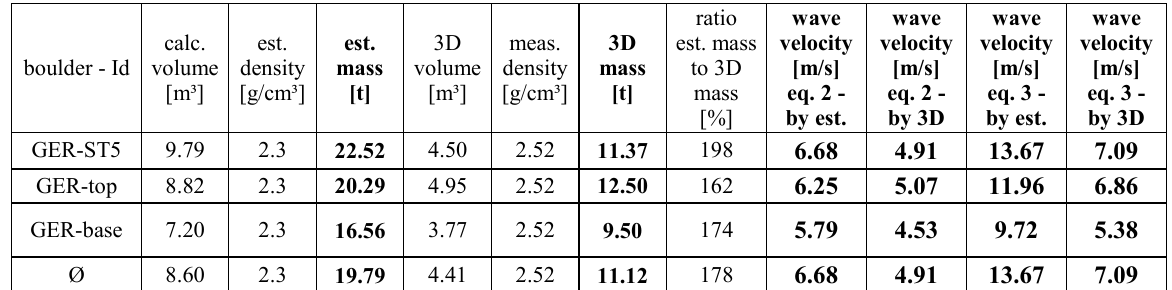
resolution digital elevation models (HRDEMs) were